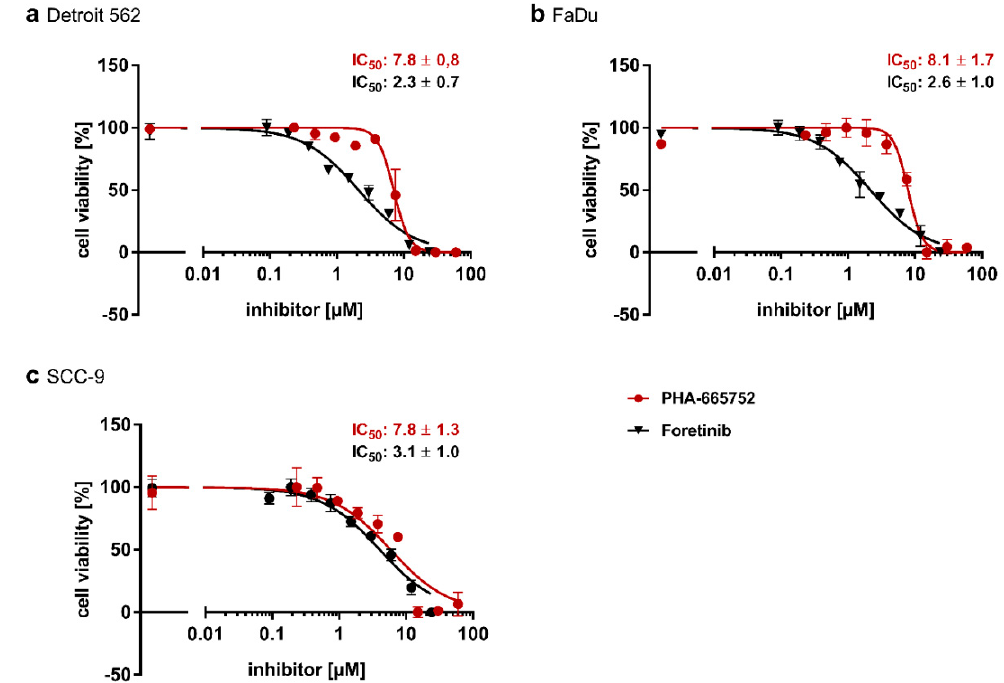
Figure 2. Concentration-dependent e ff ect of two Met kinase inhibitors on viability of cell lines Detroit 562 ( a ), FaDu ( b ), and SCC-9 ( c ). Cells were incubated with di ff erent concentrations of tyrosine kinase inhibitors PHA-665752 and foretinib or treated with medium alone (first datapoint on the left) for 48 h. Afterwards, cells were stained with crystal violet, and absorption at 595 nm was measured. Data were fitted with GraphPad Prism using nonlinear regression, log(inhibitor) vs. normalized response (variable slope), resulting in the IC 50 values shown next to the graphs. IC 50 values are means with SD of at least three independent experiments.